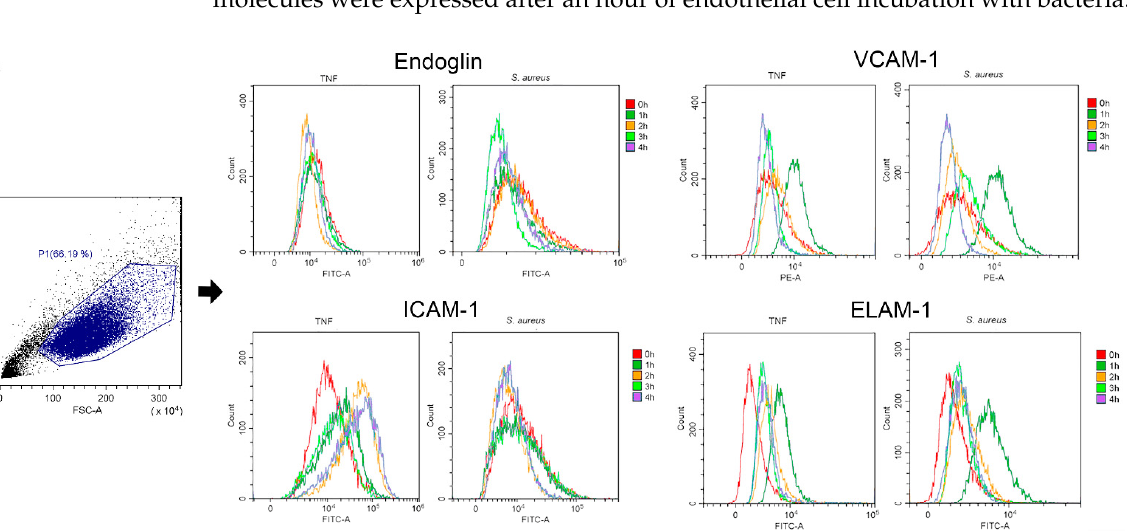
Figure 1. Flow cytometric analysis of adhesion molecules’ expression levels on the endothelial cell surface after incubation with TNF (25 ng/mL) and S. aureus 2879 M: ( A ) representative flow cytom- etry histograms for the endoglin, VCAM-1, ICAM-1, and ELAM-1 expression on the surface of EA.hy926 cells; ( B ) dynamics of endoglin, VCAM-1, ICAM-1 and ELAM-1 expression estimated us- ing median fluorescence intensity (MFI) (error bars represent SD). There were at least 4 experiments for each time point. 3.2. New System for the Study of Adhesive Contacts between EA.Hy926 Cells and Neutrophils of Healthy Donors Using FS Spectroscopy and Study of the Force and Work of Adhesion The EA.hy926 cell culture was grown until the achievement of the monolayer (the overgrowth of culture was avoided) to carry out the correct measurements as described in Section 2.2. After its growth, the culture of endothelial cells was washed three times with HBSS under microscopic control. The probe was pretreated with poly-L-lysine, which made it possible to fix the neutrophil granulocyte on the probe. The concentration of 1 × 10 6 cells/mL neutrophils in the suspension was selected in the series of preliminary experiments because, by using this concentration, only one cell was bound on the probe surface [19]. During the first experiments, the presence of adhesive contacts between the neutrophils and endothelial cells was established (see Section 2.4). The typical experi- mental curves obtained by using FS spectroscopy are shown in Figure 2.